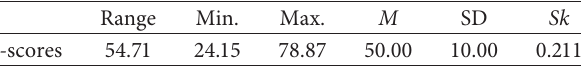
Table 2: Descriptive statistics for the participants’ academic achievement of the transformed scores.